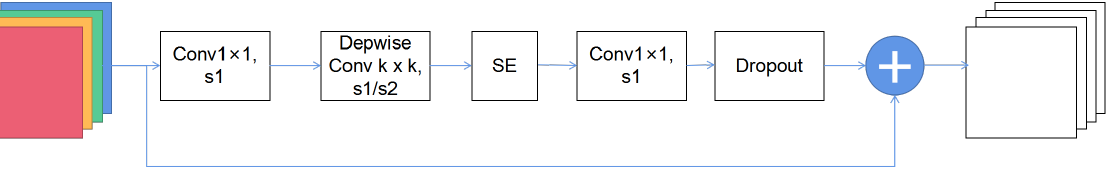
Figure 12. Structure of CNN.